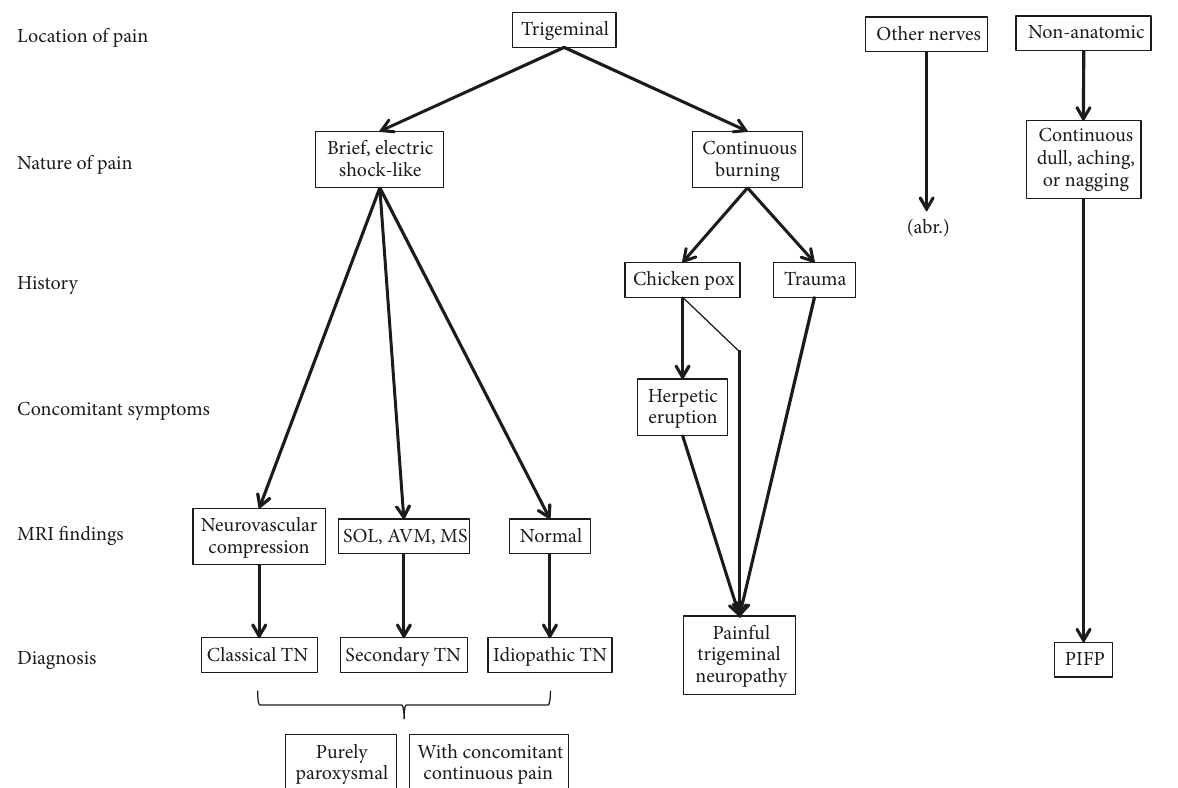
Figure 2: Diagnostic flow chart of facial pain. After injury or dental origin is excluded, advance the diagnosis following the chart. All types of TN have purely paroxysmal and with concomitant continuous pain subtypes. In our case, because we were constrained by the location of the pain (limited to the second branch of the trigeminal nerve), and the characteristics of PIFP are poorly localized, a temporary diagnosis of TN was made. However, as this chart shows, the nature of pain is also important, and enough attention should be paid to pain characteristics as well as its location. Regarding the location in our patient, we may have overlooked pain in other areas. AVM stands for arteriovenous malformation, MS stands for multiple sclerosis, PIFP stands for persistent idiopathic facial pain, SOL stands for solid occupied lesion, and TN stands for trigeminal